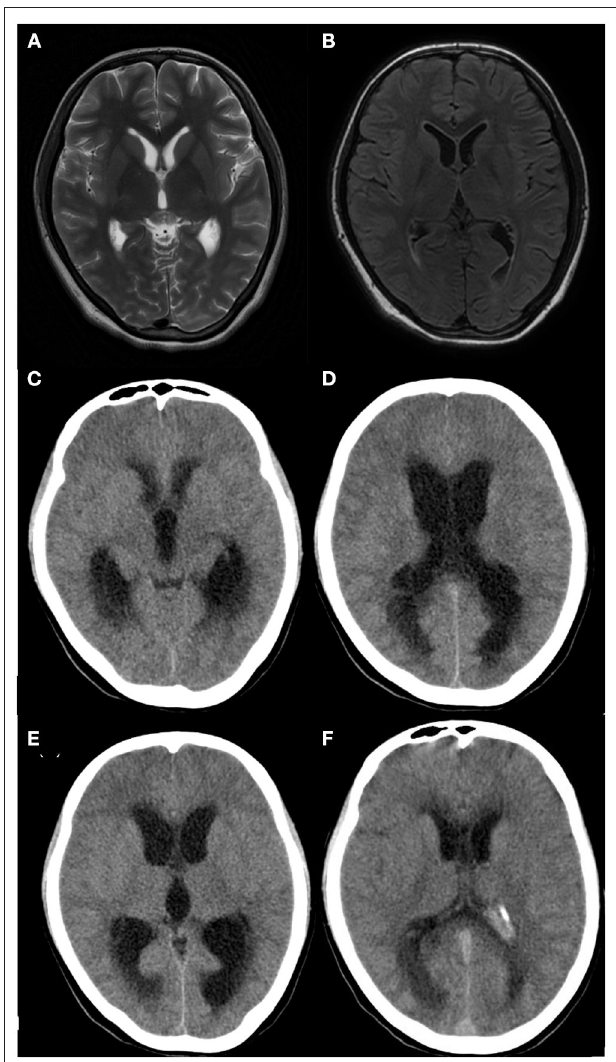
FIGURE 1 | Brain imaging of patient 8. (A,B) Brain MRI performed 16 days after clinical onset showing no apparent abnormalities, (C,D) Brain CT performed 20 days after clinical onset showing hydrocephalus and parenchymal edema, (E,F) Brain CT performed after ventricular-puncture drainage (27 days after clinical onset), Though no significant reduction of hydrocephalus was shown in panel E compared to panel C, decreased hydrocephalus was obvious in panel F compared to panel